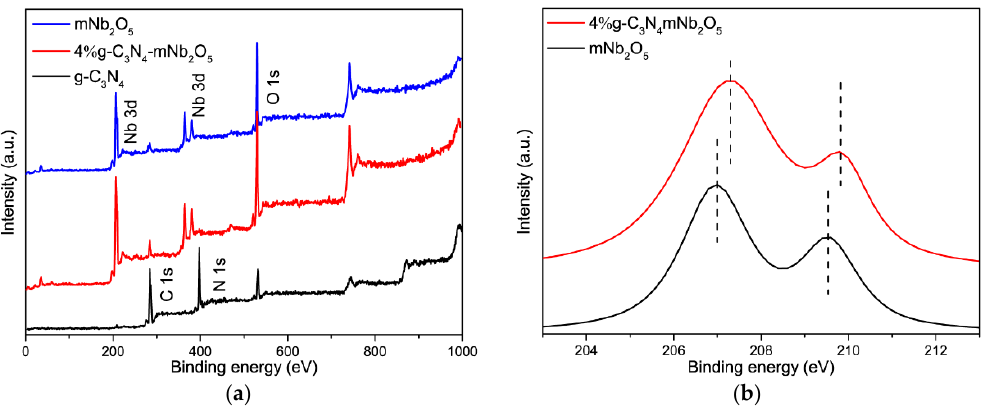
Figure 6. ( a ) XPS survey spectra of g-C 3 N 4 , mNb 2 O 5 and 4% g-C 3 N 4 -mNb 2 O 5 ; and ( b ) Nb 3d spectra for mNb 2 O 5 and 4% g-C 3 N 4 -mNb 2 O 5 .